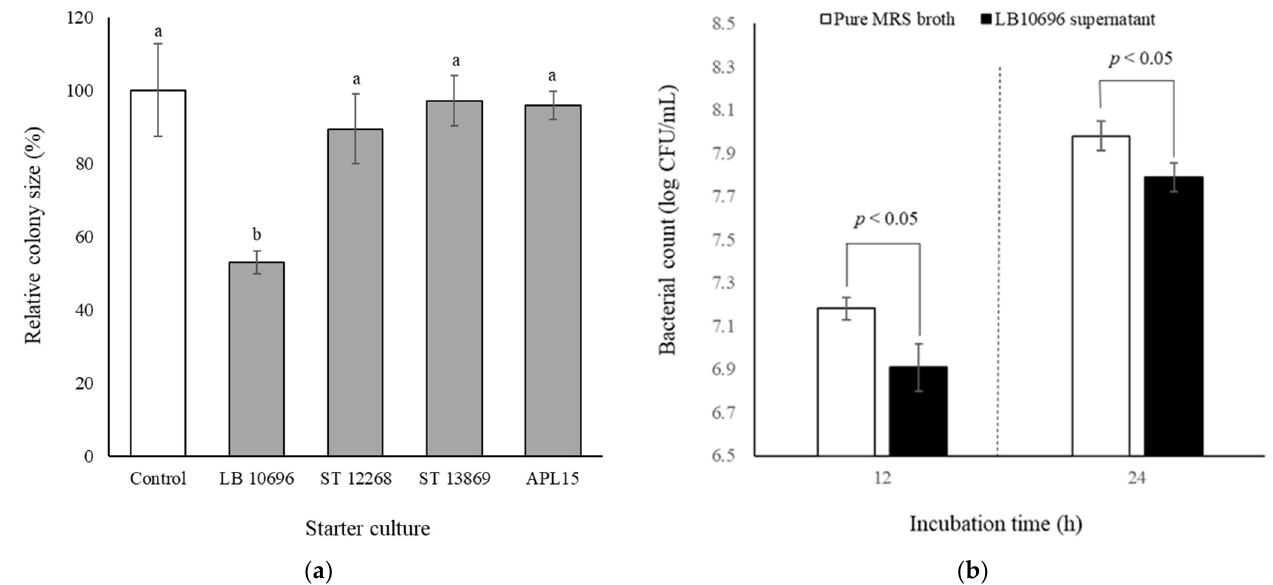
Figure 1. Effect of starter cultures on the growth of L. kefiranofaciens HL1 incubated in MRS medium. ( a ) Relative colony size of L. kefiranofaciens HL1 when culturing alone (control) and co-culturing with different starter cultures on MRS agar at 30 °C for 72 h. Data are given as mean ± SD ( n = 3). a,b bars without the common letter are significantly different ( p < 0.05). ( b ) Viable bacterial count of L. kefiranofaciens HL1 in pure MRS broth and in MRS broth with 10% filtered supernatant from cultures of LB 10696 at 30 °C for 12 and 24 h. Data are given as mean ± SD ( n = 3). Abbreviations: LB 10696, L. delbrueckii subsp. bulgaricus BCRC 10696T; ST 12268, S. thermophilus BCRC 12268; ST 13869, S. thermophilus BCRC 13869T; APL15, Lc. lactis subsp. cremoris APL15.